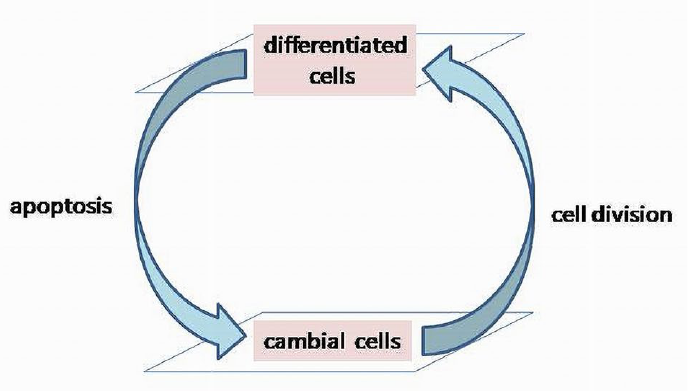
Figure 3. Cell Renewal Cycle